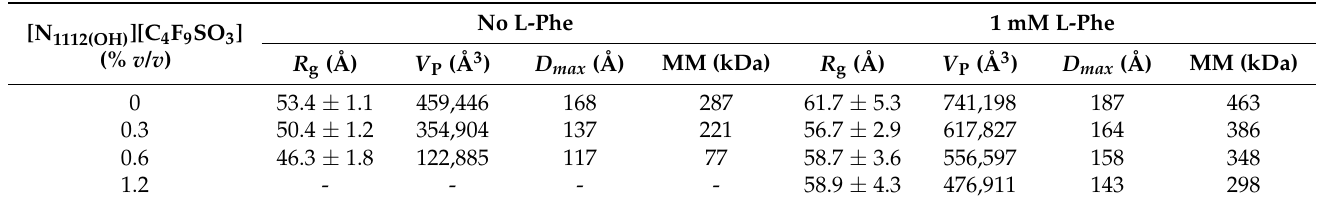
Table 5. SAXS structural parameters of hPAH in the presence and absence of [N 1112(OH) ][C 4 F 9 SO 3 ] and L-Phe. Radii of gyration ( R g ) were estimated from the Guinier approximation. Excluded particle volumes ( V P ) were estimated from the Porod approximation. Maximum particle dimensions ( D max ) were obtained from the pair-distribution function. Molecular mass (MM) values were derived from the Porod volume as MM =